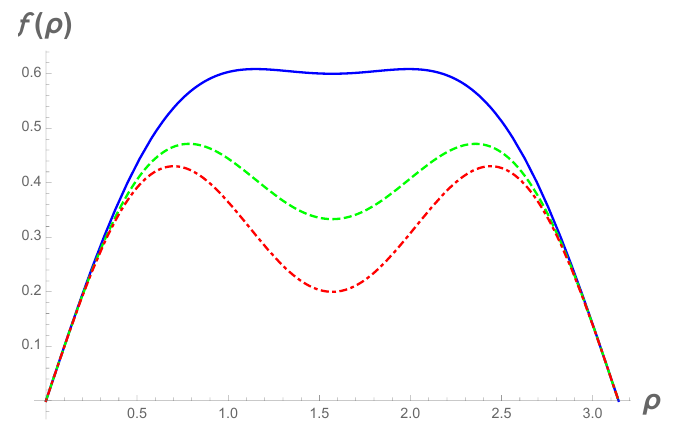
Figure 2 . The function f ( (cid:26) ) is plotted for (cid:14) = 1 = 5 (solid, blue), 1 = 3 (dashed, green), 2 = 5 (dot- dashed,